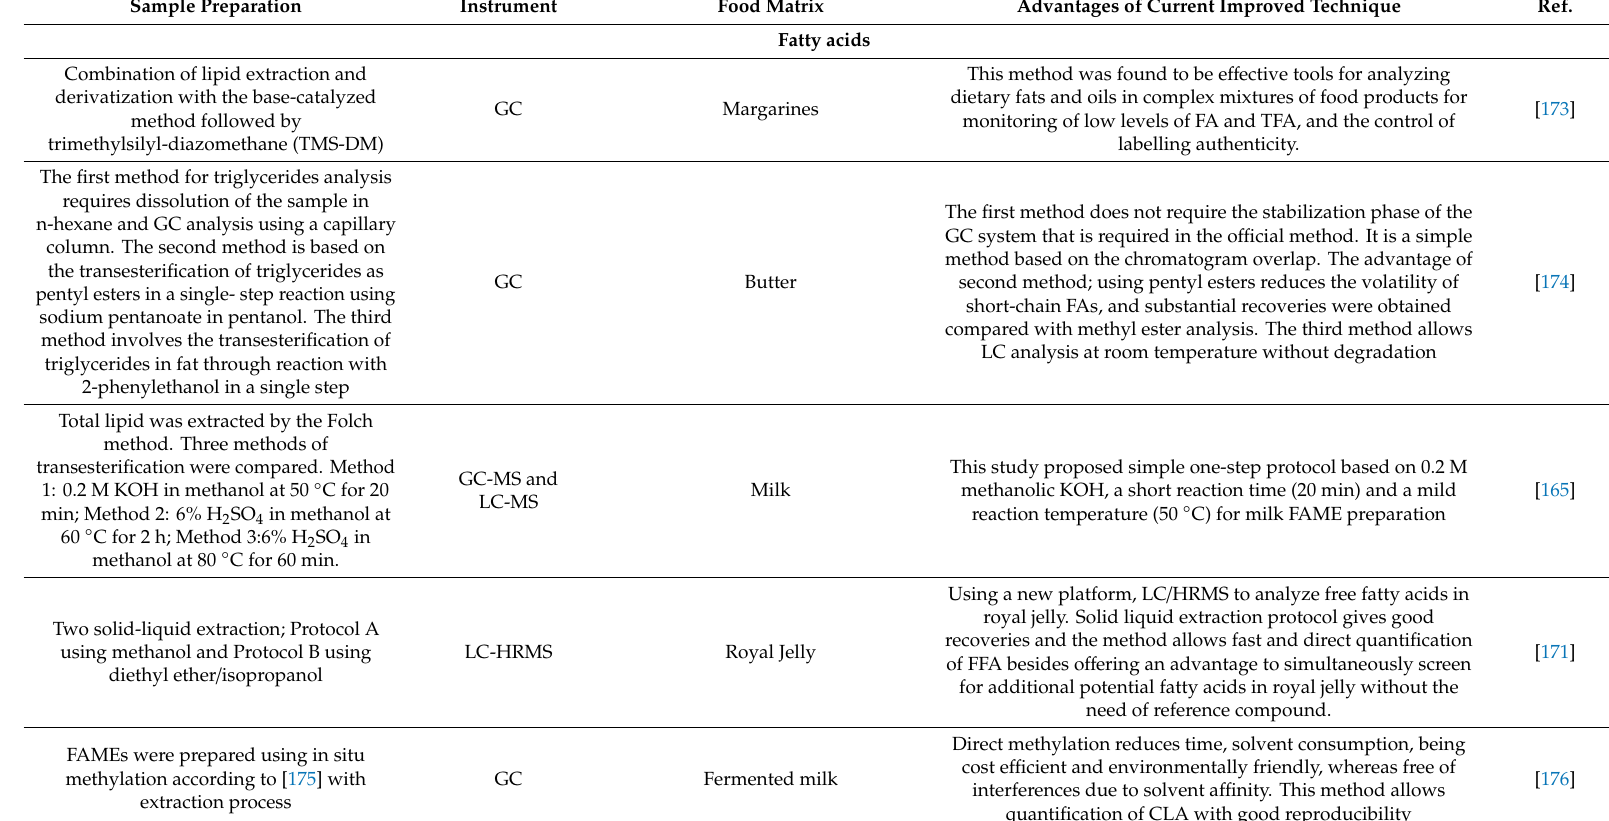
Table 6. Methods, food matrices and advantages of current improved technique for fatty acids and